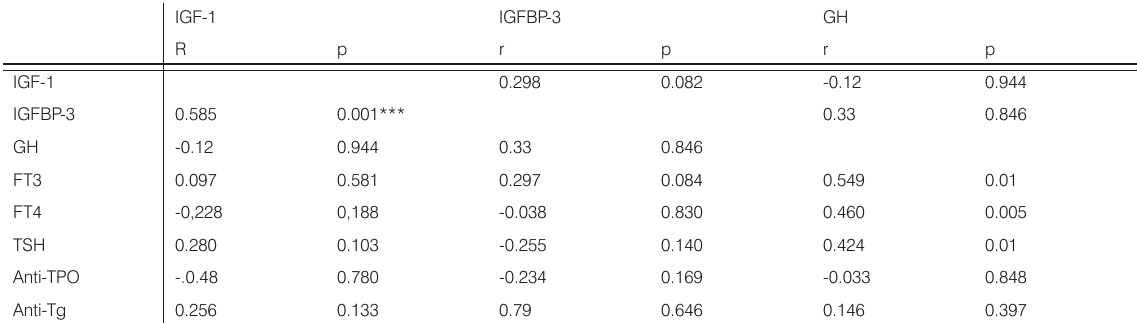
Table 2. The correlations among GH, IGF-1, IGFBP3 and thyroid hormones and antibodies in patients with subclinical hypothyroidism.